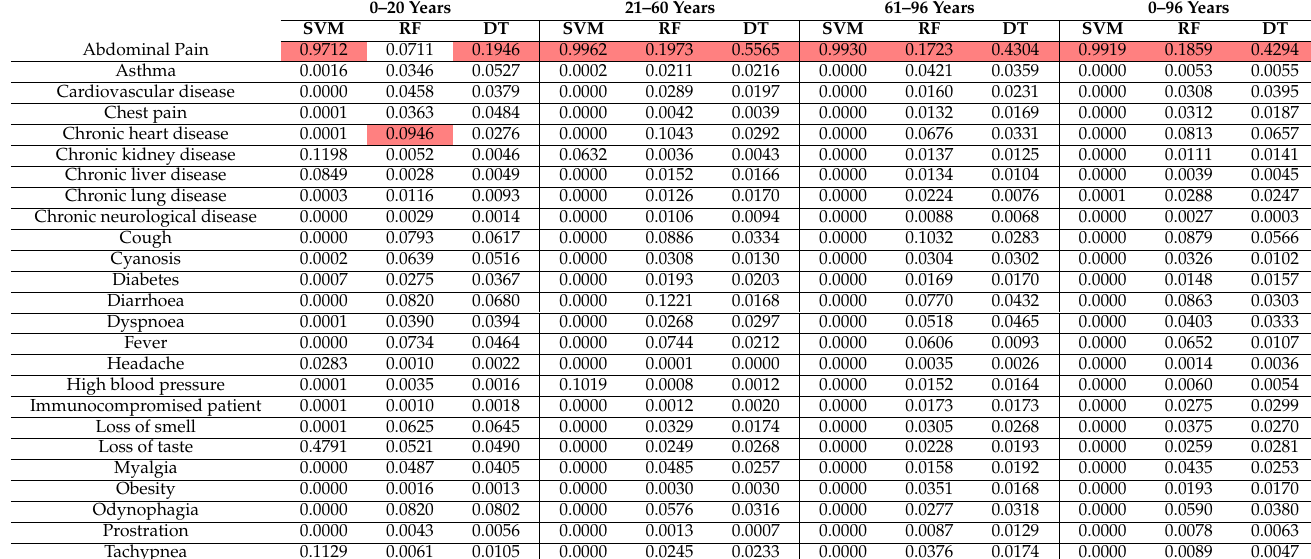
Table 5. SVM, RF and DT accuracy results categorized by age range. Intense red indicates the highest